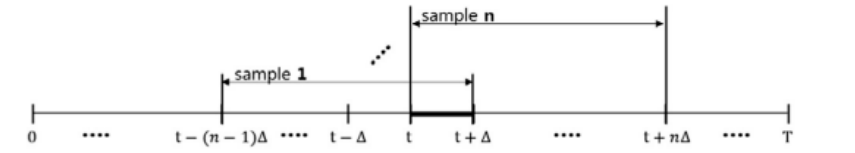
Figure 1. The time range [ t , t + (cid:52) ] included in n sample windows. Reprinted from [13], Copyright (2015), with permission from